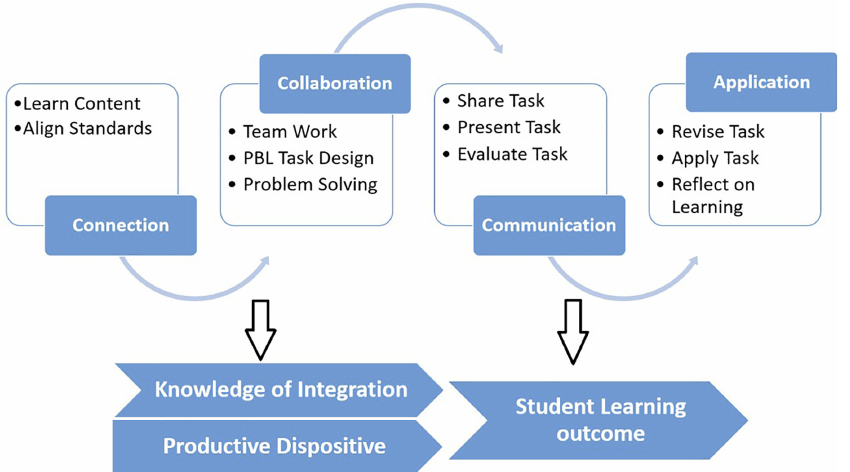
Figure 1. Conceptual